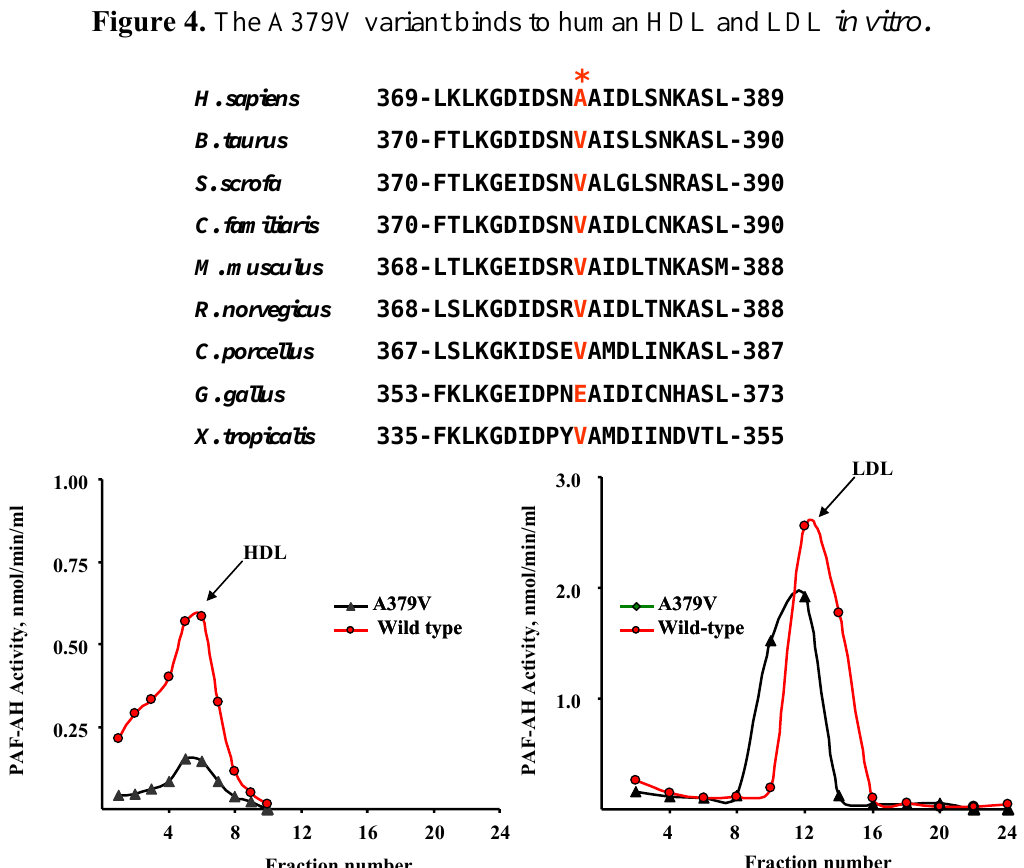
Figure 4. The A379V variant binds to human HDL and LDL in vitro.